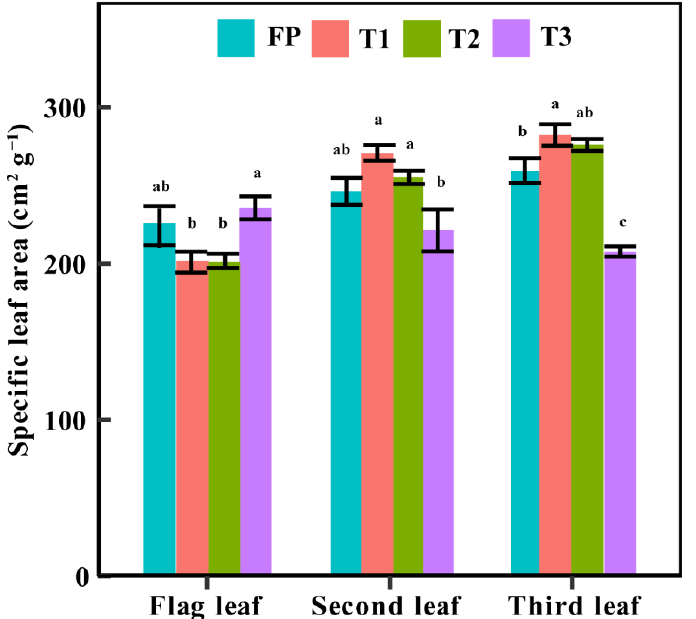
Figure 3. Specific leaf area of the top three leaves at anthesis under different treatments in 2017–2018 growing season. Different letters in the figure indicate statistical differences among treatments (LSD p < 0.05 ).